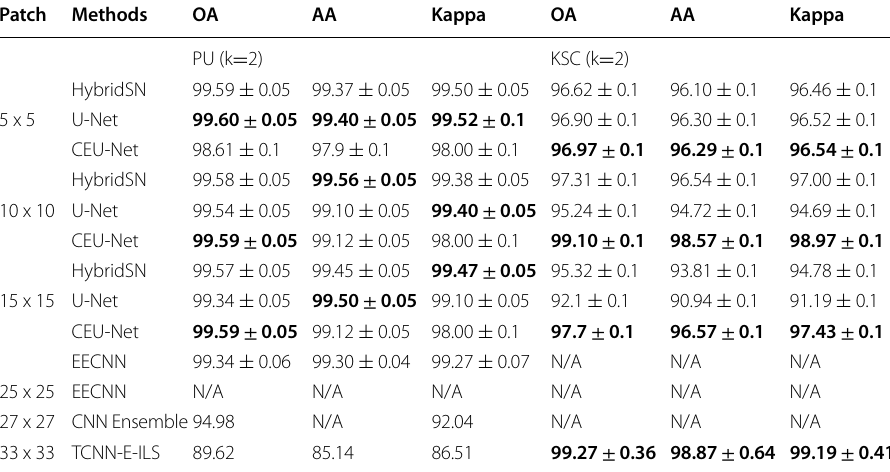
Highest performing values are highlighted in bold